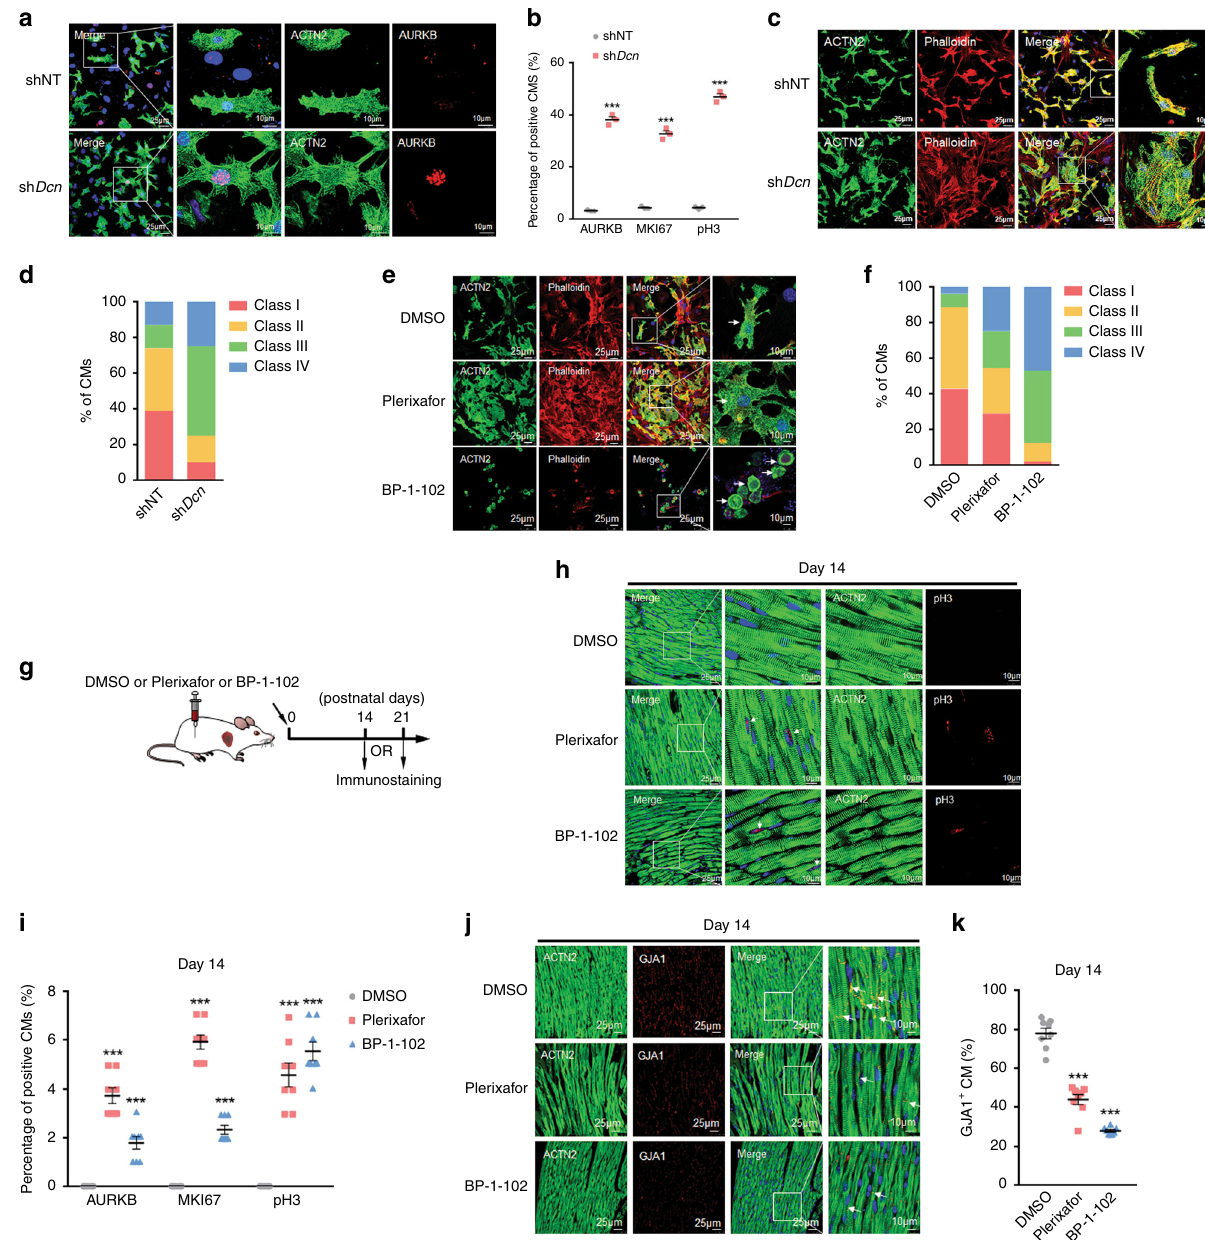
Fig. 7 Targeted inhibition of conserved pathways impairs maturation. a Immuno fl uorescent (IF) staining against ACTN2 and AURKB in imCMs-AF upon transfection with shNT and sh Dcn , respectively. Scale bars = 25 or 10 μ m. b Quanti fi cation of ACTN2 + AURKB + ( a ), ACTN2 + MKI67 + (Supplementary Fig. 5b) or ACTN2 + pH3 + (Supplementary Fig. 5c). Data are plotted as mean ± SEM from three independent experiments, *** p < 0.001, two-sided Student ’ s t -test. c Immunostaining against ACTN2 and Phalloidin in imCMs 3.5 days after co-culture with AFs upon depletion of NT (shNT) or Dcn (sh Dcn ), respectively. d Percentages of CMs in different morphology grades in c . e Immunostaining against ACTN2 and Phalloidin in imCMs 3.5 days after co- culture with AFs in the presence of DMSO, Plerixafor or BP-1-102, respectively. f Percentage of CMs in different morphology grades in e . g Work fl ow of animal experiment. Neonatal (P1) mice were treated with DMSO, Plerixafor or BP-1-102 daily for 14 (Day 14) or 21 days (Day 21), respectively. Mice were sacri fi ced for immunostaining of heart sections at P14 or P21, respectively. h Immuno fl uorescent staining against ACTN2 and pH3 in heart sections from mice at P14. White arrows indicate co-localization. Scale bar = 10 or 25 μ m. i Quantif i cation of ACTN2 + AURKB + , ACTN2 + MKI67 + , and ACTN2 + pH3 + cells . Data are plotted as mean ± SEM, n = 8 biologically independent mice, *** p < 0.001, two-sided Student ’ s t -test. j Immuno fl uorescent staining of ACTN2 and GJA1 in heart sections of mice treated with DMSO, Plerixafor or BP-1-102 for 14 days, respectively. White arrows indicate co-localization. Scale bars = 10 or 25 μ m. k Quanti fi cation of ACTN2 + GJA1 + cells in j , Data are plotted as mean ± SEM, n = 8 biologically independent mice, *** p < 0.001, two- sided Student ’ s t -test. Source data are provided as a Source Data fi